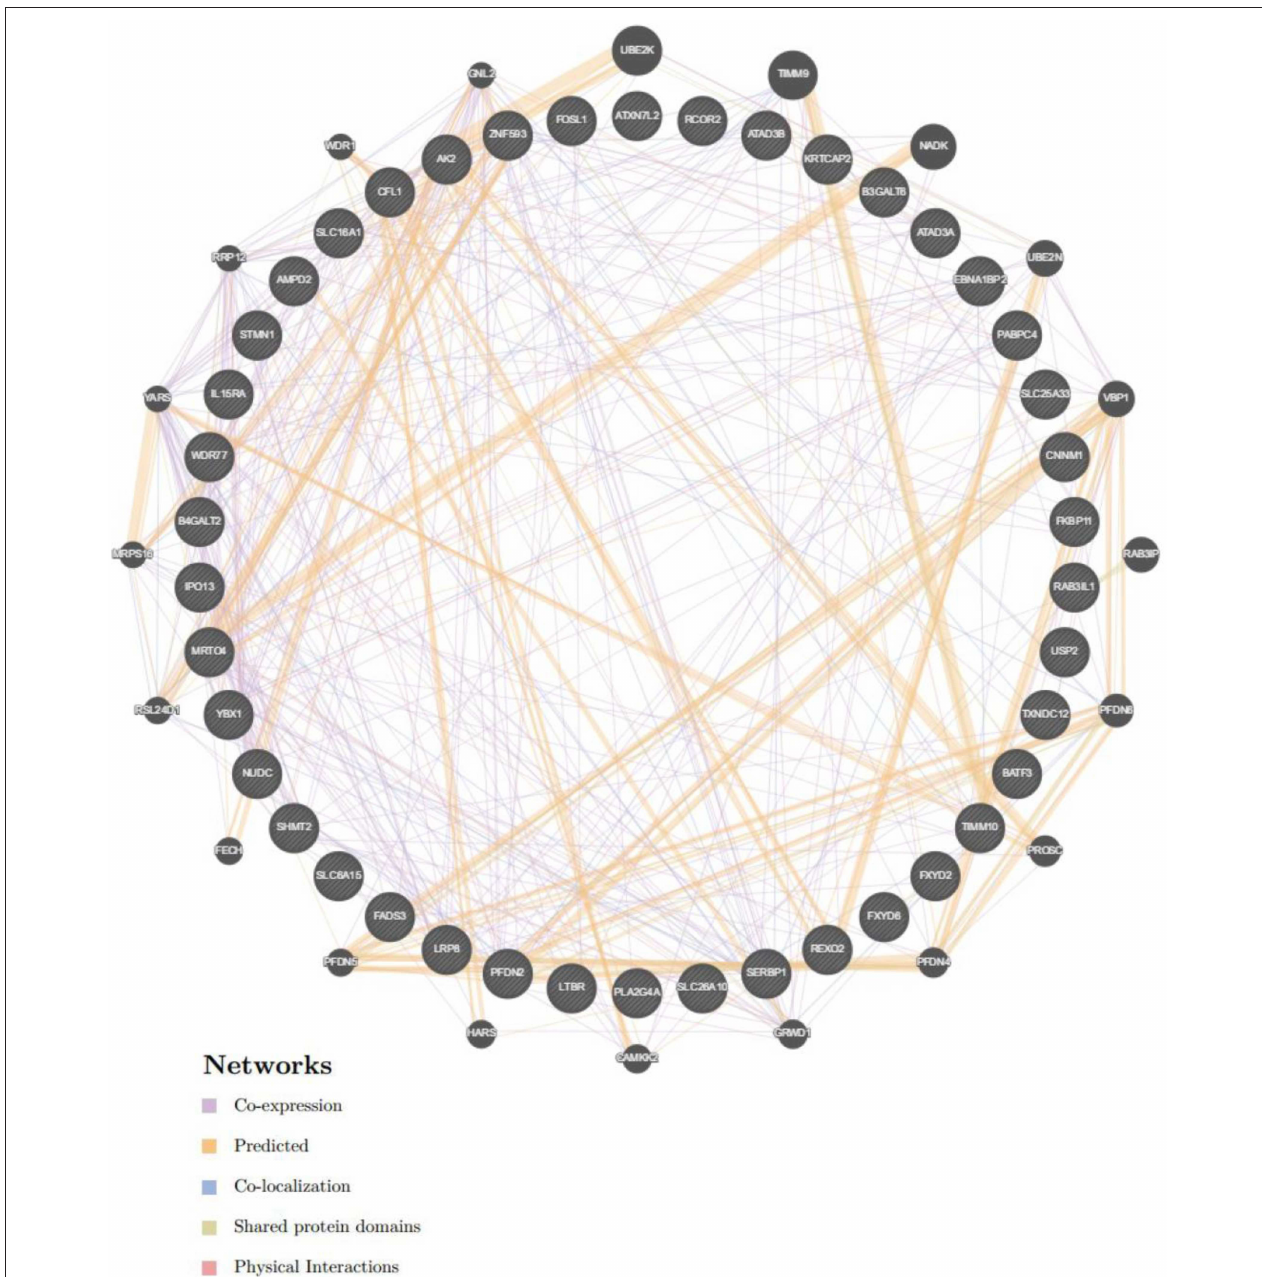
FIGURE 10 | Protein-protein interaction network of transcription factor MYC-target networks construction (GeneMANIA). Protein-protein interaction (PPI) network illustrates the gene set that was enriched in the target network of MYC. Different colors of the network edge represent the bioinformatics methods applied including co-expression, website prediction, co-localization, shared protein domains, and physical